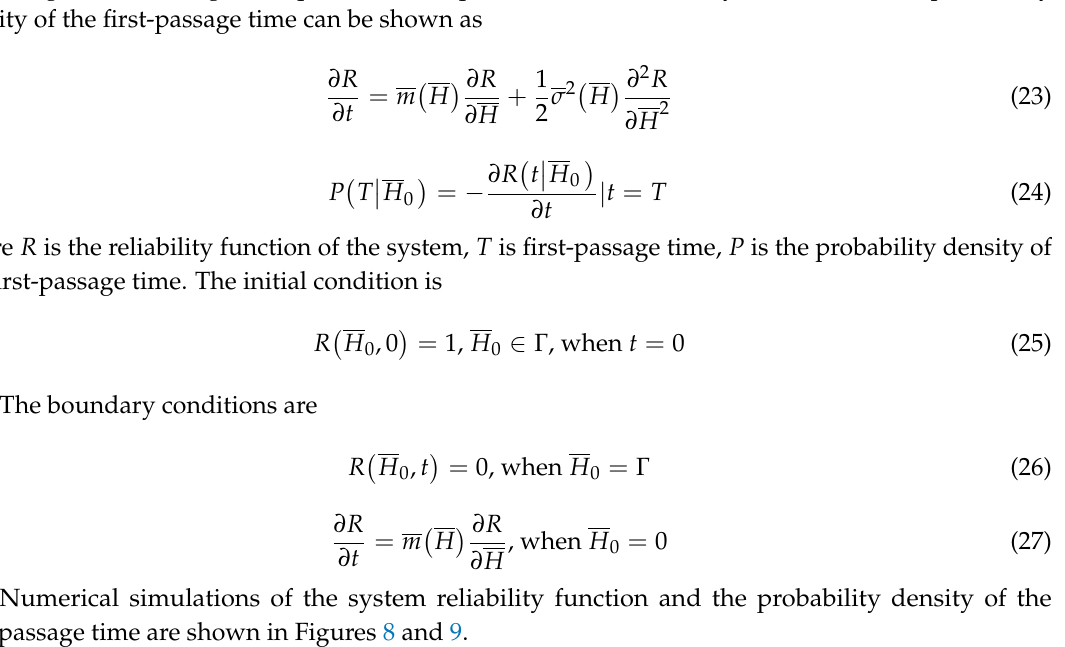
Figure 7. Safe basin of the system when e = 0.8.